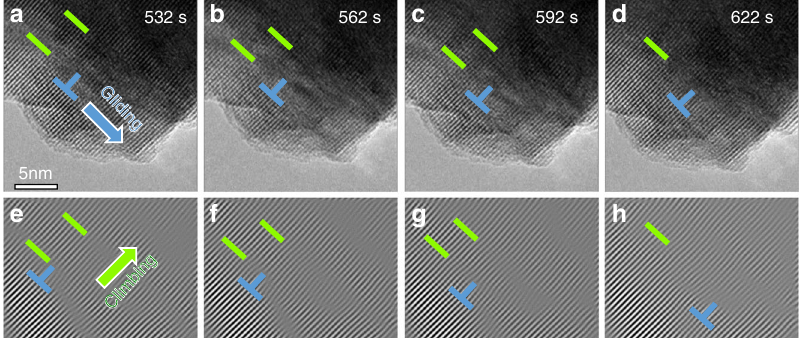
Fig. 3 Dynamic gliding and transverse movement ( “ climbing ” ) of a c /2[001] dislocation during delithiation. a – d Time-lapsed high-resolution episcopic microscopy (HREM) images. e – h Corresponding Fourier- fi ltered images of a – d , showing only the (001) lattice plane fringes. Gliding, climbing, and merging of the dislocations towards the surface prompts the formation and release of O 2 gas. The scale bar is 5